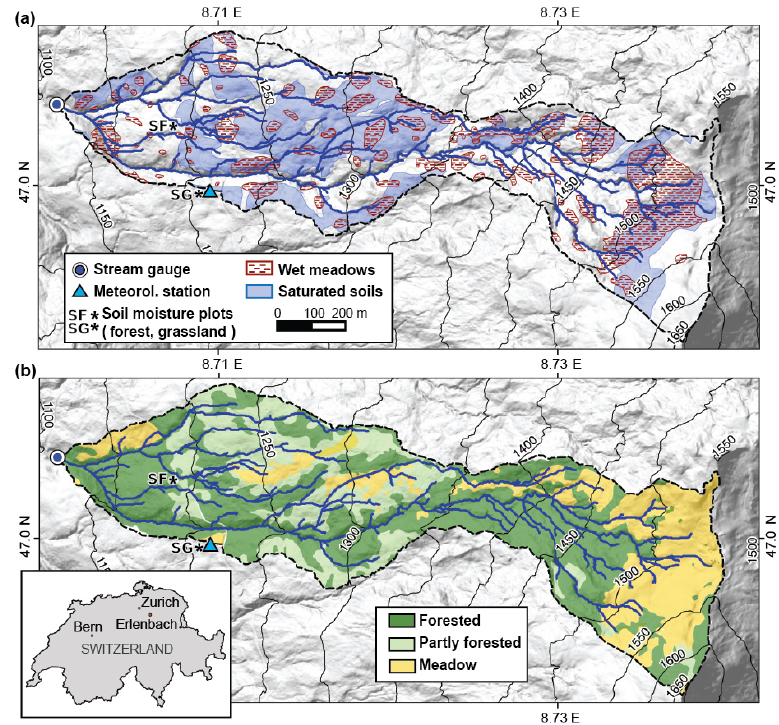
Figure 1. The Erlenbach catchment with spatial distribution of (a) saturated soils (FOEN, 2011), mapped wet meadows and (b) vegetation (Fischer et al.,